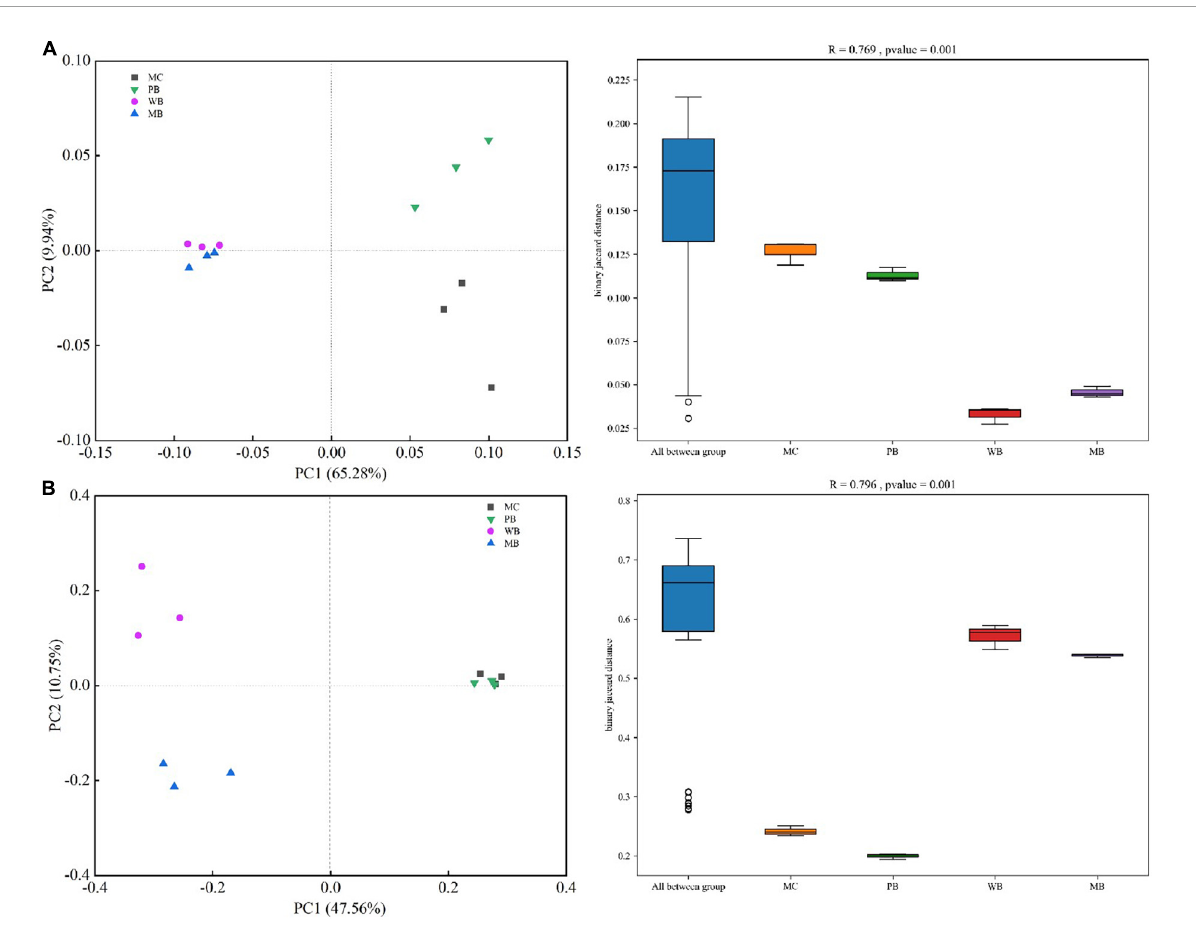
FIGURE5 Principal coordinate analysis (PCoA) ordinations based on unweighted UniFrac distance metric and analysis of similarity (ANOSIM) based on binary Jaccard distance of bacterial (A) and fungal (B) community composition of the rhizosphere soil sampled on the 3-year following soil amendment at 20 t ha − 1 . MC, amendment of manure compost at 20 t ha − 1 ; PB, WB, and MB, amendment of pig manure, wood, and maize biochar at 20 t ha − 1